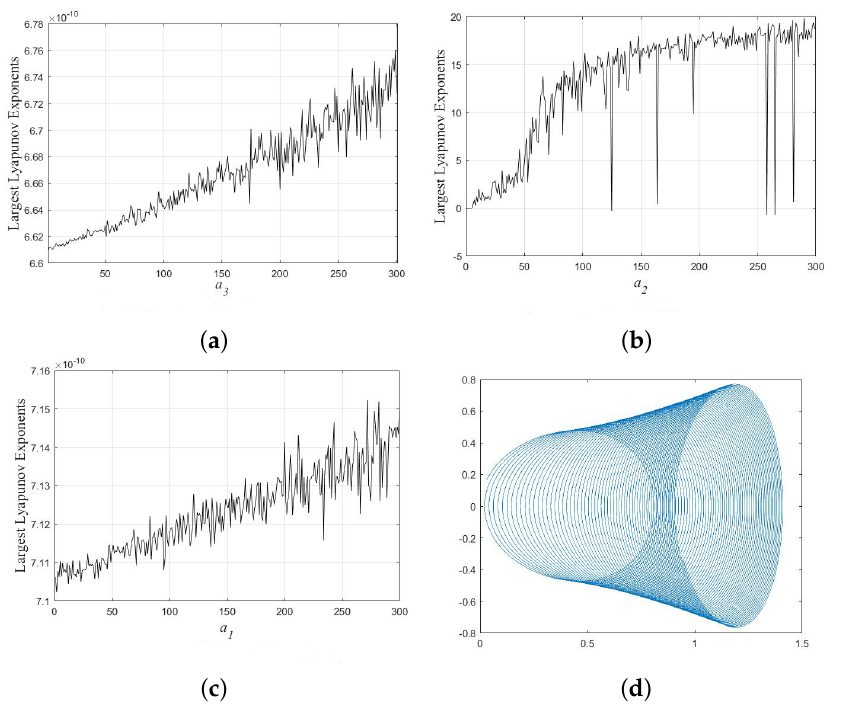
Figure 5. System (7): ( a ) Largest Lyapunov Exponents for a 3 ; ( b ) Largest Lyapunov Exponents for a 1 ; ( c ) Largest Lyapunov Exponents for a 2 ; ( d ) Phase portrait, when a 1 = − 0.80357, a 2 = − 0.4, a 3 = − 1.7149, R 1 ( ξ ) = e 0.01 ξ